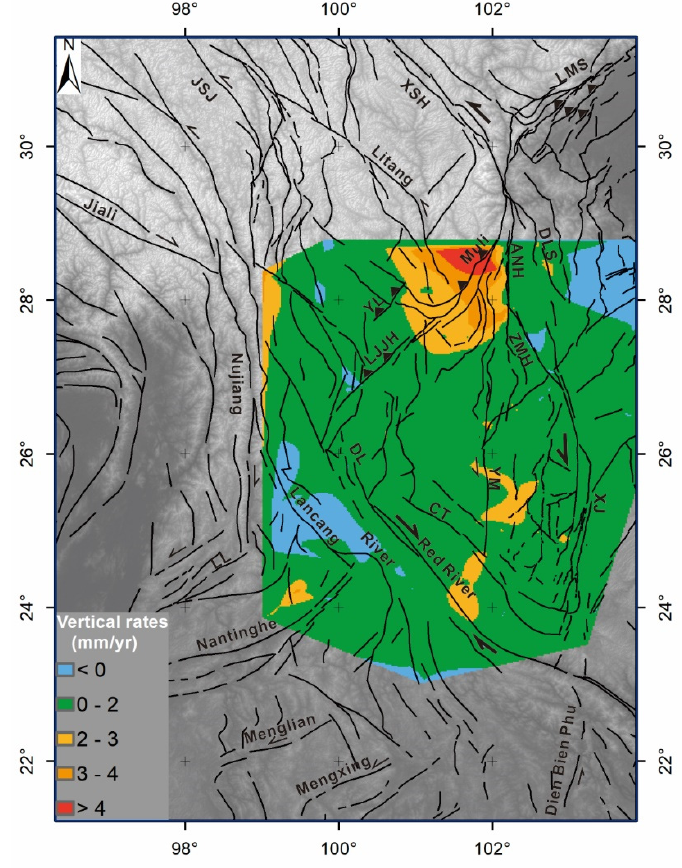
Figure 6. Interpolated vertical rates derived from the leveling survey from 1970 to 2012 in SETP were shown with arrows (Modified after Hao et al. [73]). Vertical velocities are relative to ITRF 2008. The age and position of a fluvial terrace with respect to a reference level provide a good approximation of the river incision rate. In certain occasions, this is a valid time-averaged proxy for the surface uplift rate [74]. This is especially true for the fluvial terraces that formed during the late Quaternary. Terrace formation represents a change in fluvial activity from lateral erosion or aggradation to vertical incision and abandonment of the former riverbed [64]. The incision is caused primarily by an increase in the stream power of the river, which may be a result of either (1) an increase in the ratio of water to sediment supply, which might occur during a period of climate change, (2) an increase in gradient due to tectonic uplift, or (3) a combination of the two [75–77]. Here we compared Quaternary incision rates derived from fluvial terrace dating data from SETP (Figure 7), which are closer to the geomorphic indices’ time relevance. Based on the erosion rates (see the location of the white dots), we interpolated the data within SETP into a map view.